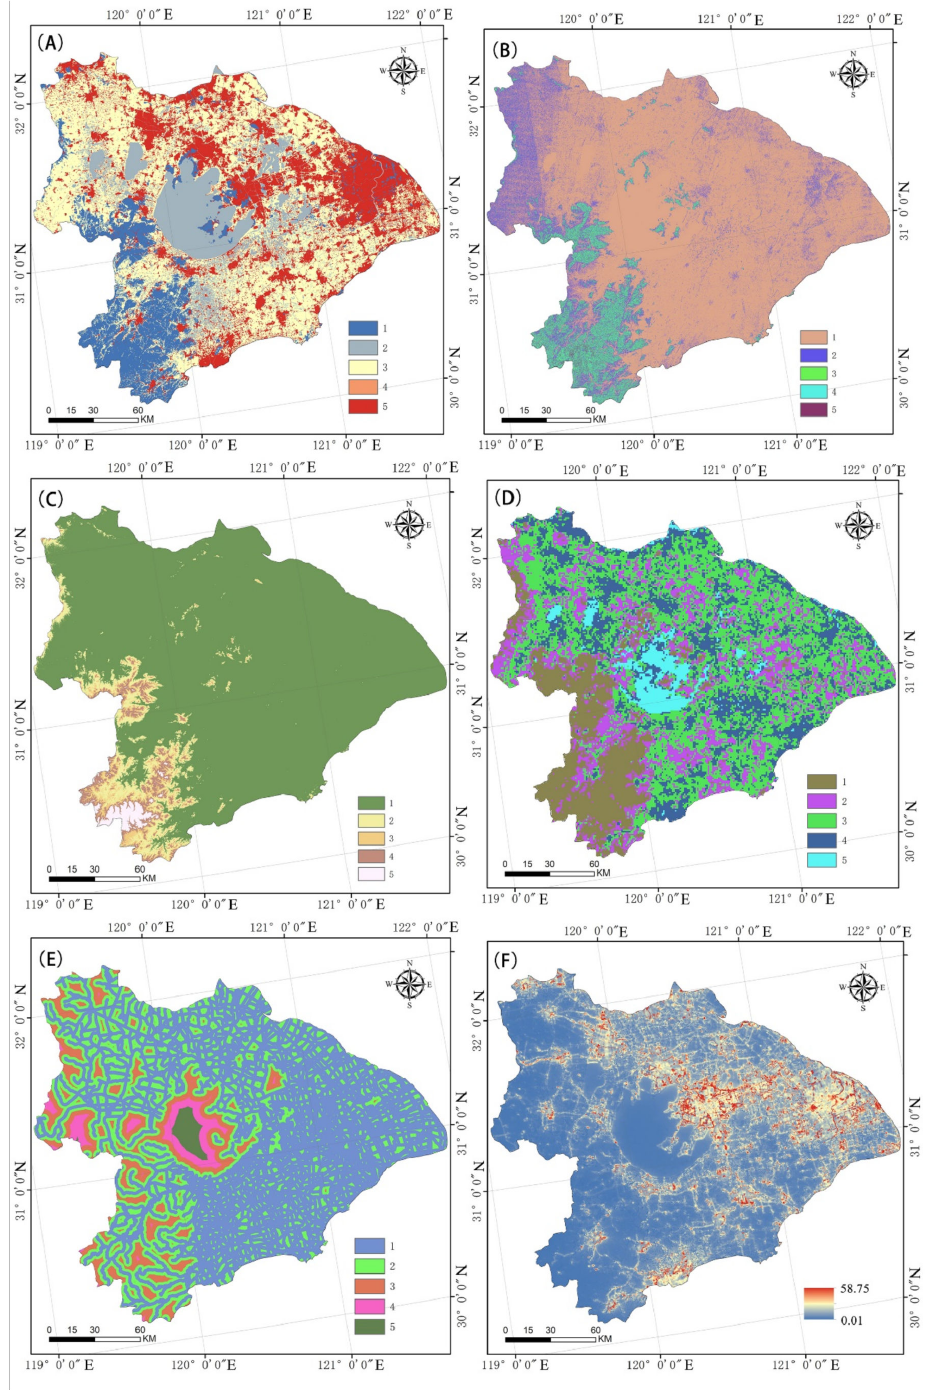
Figure 3. Various resistance factors around Taihu Lake Basin: ( A ) Land-use type resistance; ( B ) slope resistance; ( C ) elevation resistance; ( D ) NDVI resistance; ( E ) distance resistance to water; and ( F ) night light